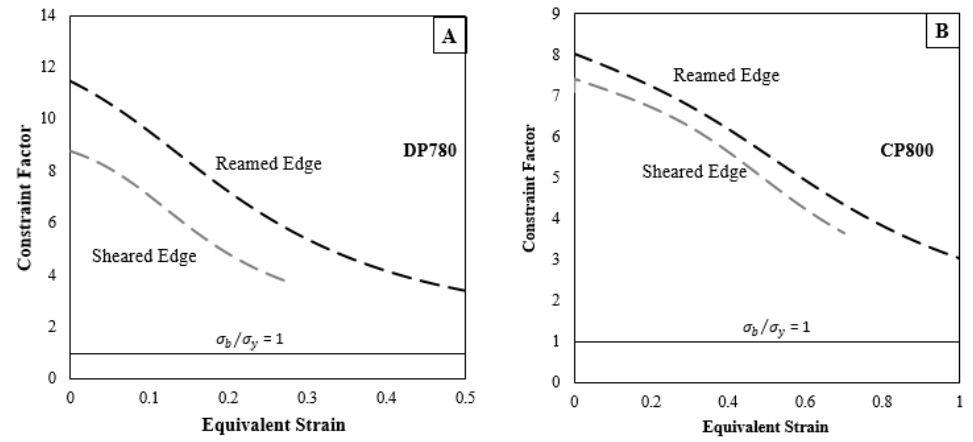
Figure 27. Constraint factor for the reamed and sheared edges of the ( A ) CP800 and ( B ) DP780 steels using Equation (7).